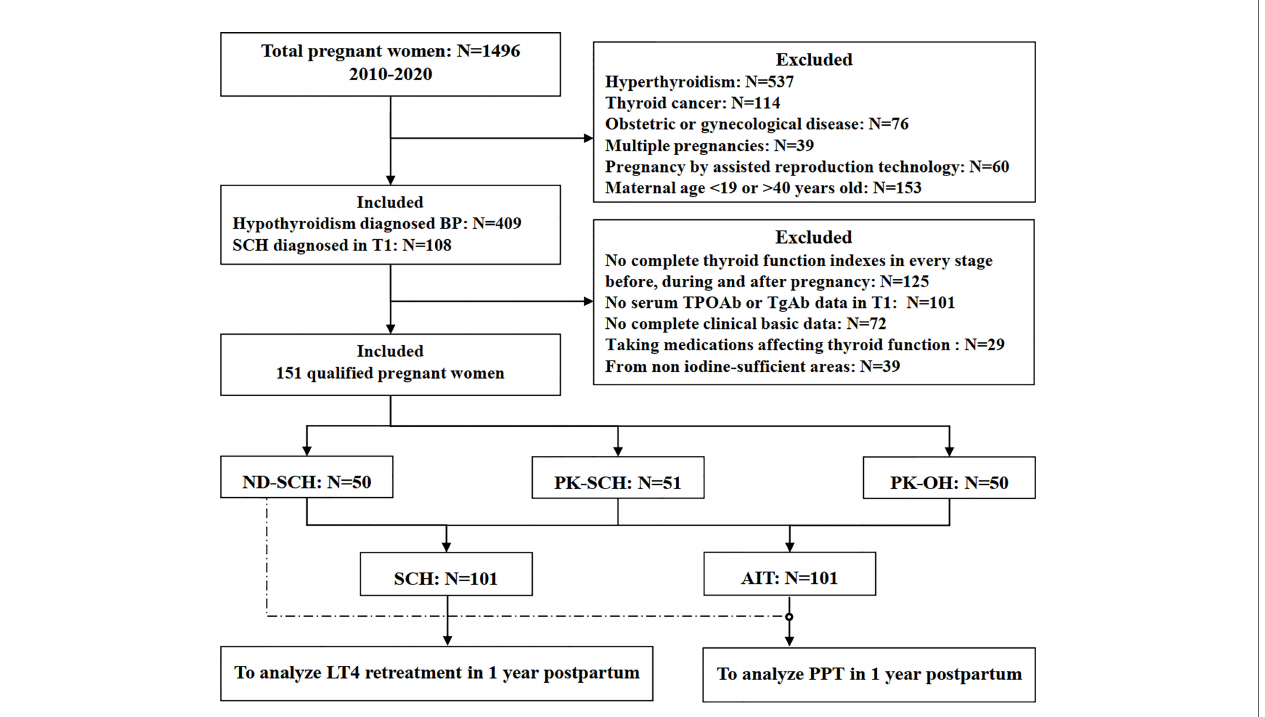
FIGURE 1 | Flow chart of the study population. BP, before pregnancy; T1, early pregnancy; TPOAb, thyroid peroxidase antibody; TgAb, thyroglobulin antibody; SCH, subclinical hypothyroidism; ND-SCH, subclinical hypothyroidism newly diagnosed in early pregnancy; PK-SCH, previously known subclinical hypothyroidism before pregnancy; PK-OH, previously known autoimmune overt hypothyroidism; AIT, autoimmune hypothyroidism diagnosed before pregnancy; PPT, postpartum